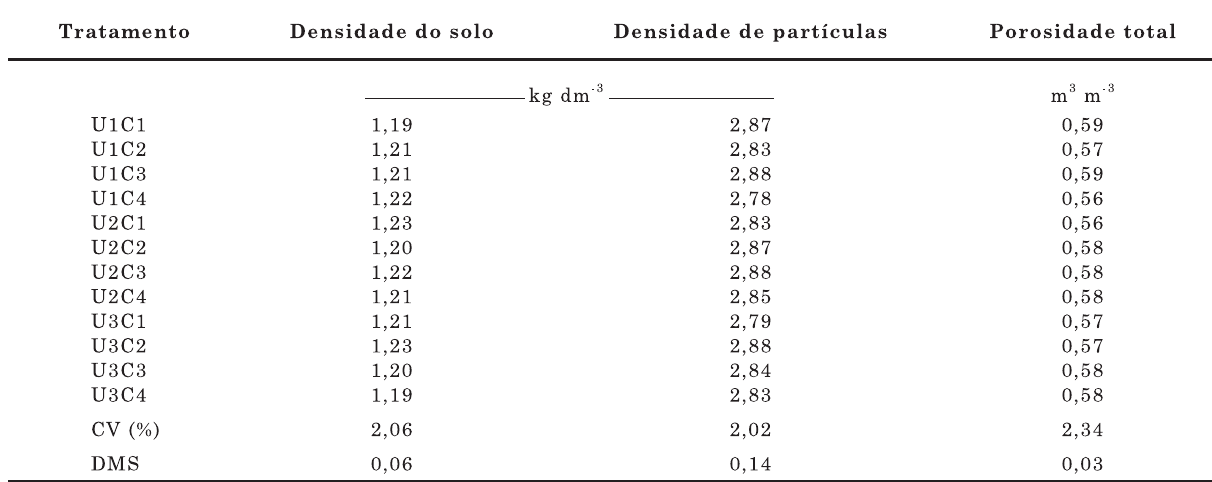
Quadro 1. Densidade do solo, densidade de partículas e porosidade total para todos os tratamentos na camada de 0 a 15